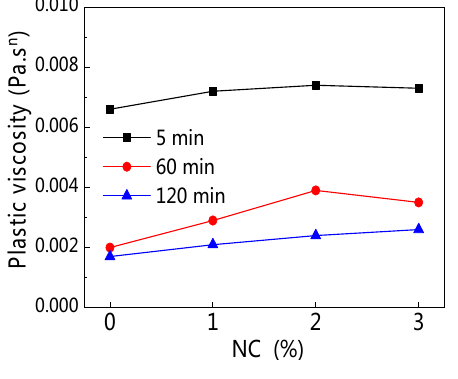
Figure 18. Influence of NC on K.